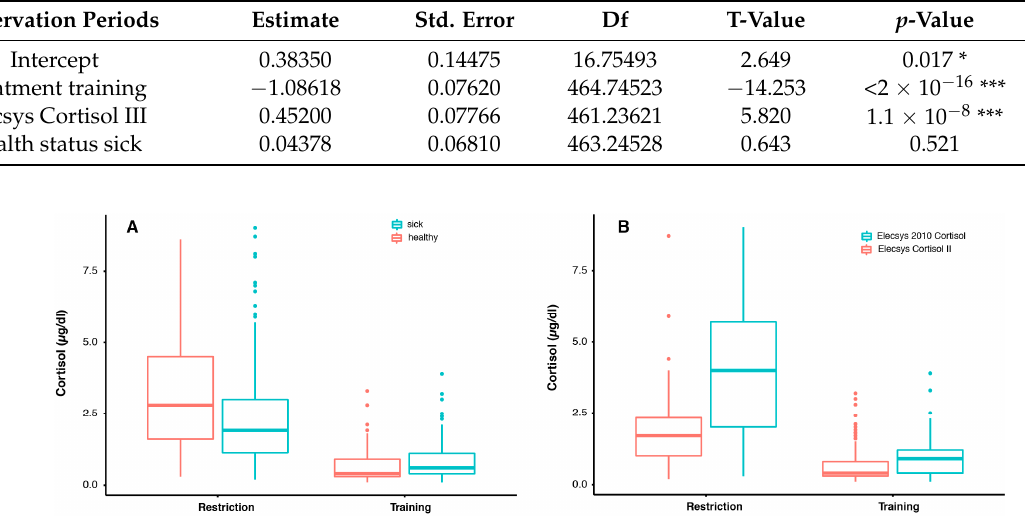
Table A3. Tukey’s pairwise post hoc comparisons for feeding experiment II; see Figure 9. Contrast